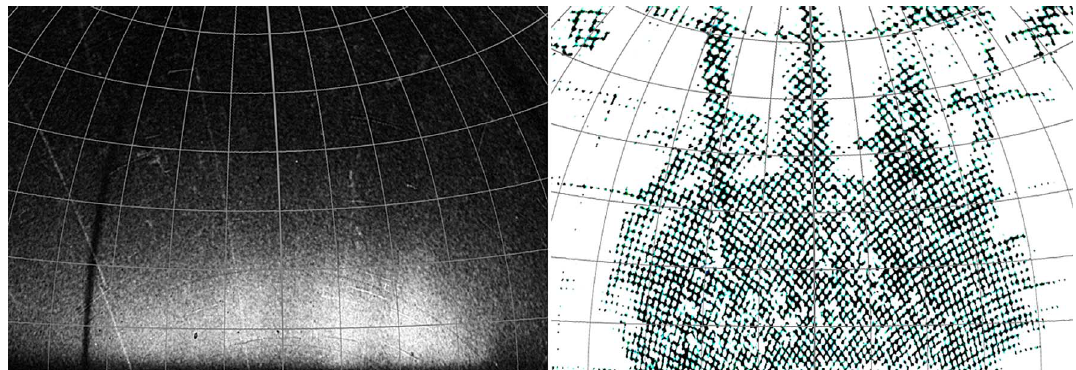
Fig. 2. Coordinate transformed photograph (top, 1044 UT) and hand-made sketch (bottom, 1037 UT) of the auroras, as observed from Memambetsu Magnetic Observatory on February 11, 1958, at a view looking toward the geographic north. Elevation angle and azimuth angle grids are shown every 10 (cid:1)